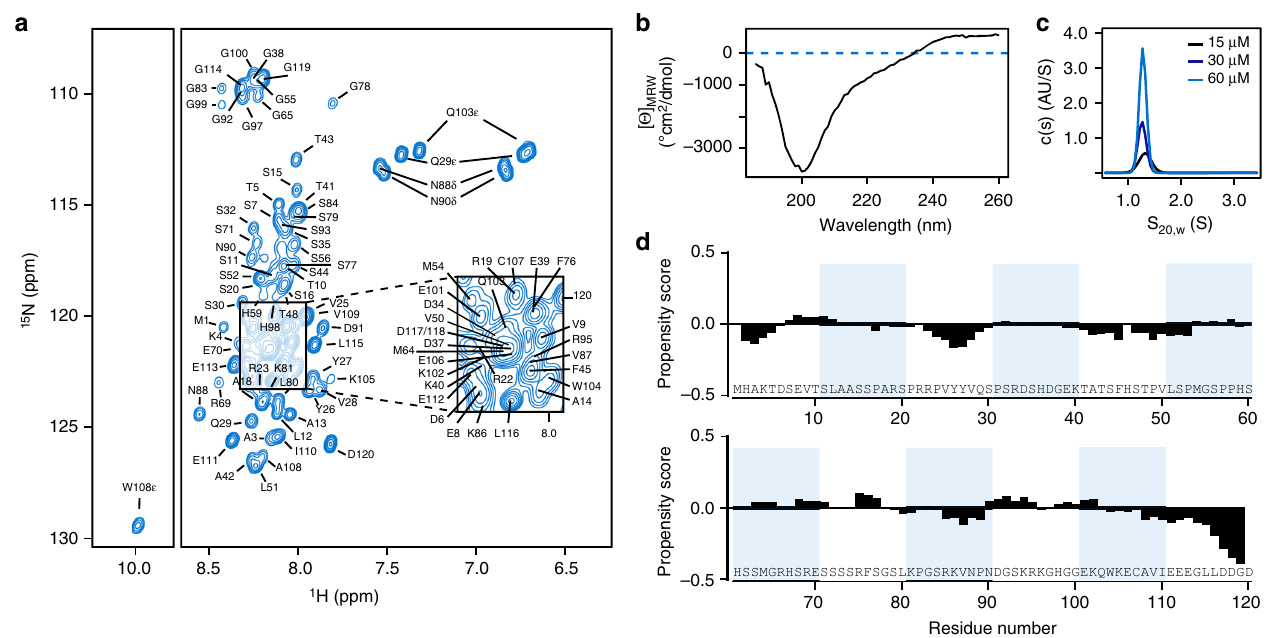
Fig. 3 Structural characteristics of the CC1 N-terminus. a Assigned 1 H – 15 N HSQC spectrum of 15 N-labeled CC1 Δ C223 in solution. The low signal dispersion in the 1 H dimension is characteristic of an intrinsically disordered protein. b Circular dichroism (CD) spectrum of 6xHis-CC1 Δ C223 in solution supporting lack of clear structures in the protein. c Analytical ultracentrifugation at three different CC1 Δ C223 concentrations showed a single size population at the approximate molecular weight of monomeric CC1 Δ C223. The frictional coef fi cient of 1.7 is characteristic for elongated protein shapes. d Structural propensity plot of CC1 Δ C223 calculated by ncSPC 27 using Δδ C α , Δδ C β and Δδ C ’ secondary chemical shifts (Supplementary Fig. 4b – d). Propensity scores of 1 and − 1 report on fully formed α - or β -structure,